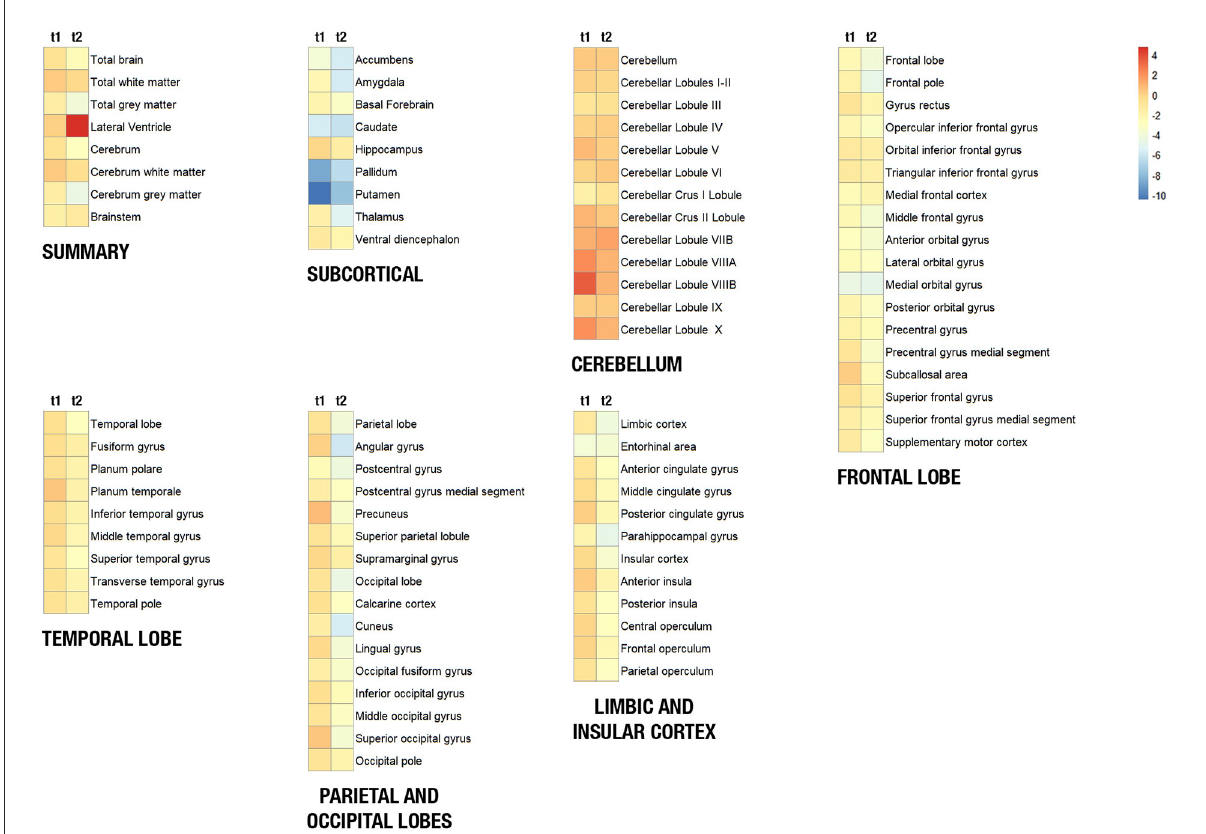
FIGURE1 Heat maps showing the volume of brain structures of the patient with juvenile Huntington’s disease at 18 years (t1) and 21 years (t2). Brain structures were clustered in seven regions (summary, frontal lobe, temporal lobe, parietoccipital lobe, limbic and insular cortex, subcortical region, and the cerebellum). The blue-to-red scale indicates lower to higher intensity levels based on a Z -score of normalized volumes for each structure. Red/orange squares represent that the patient’s structure volume is higher than its mean volume in controls, and yellow/blue squares represent that the patient’s structure volume is lower than its mean volume in